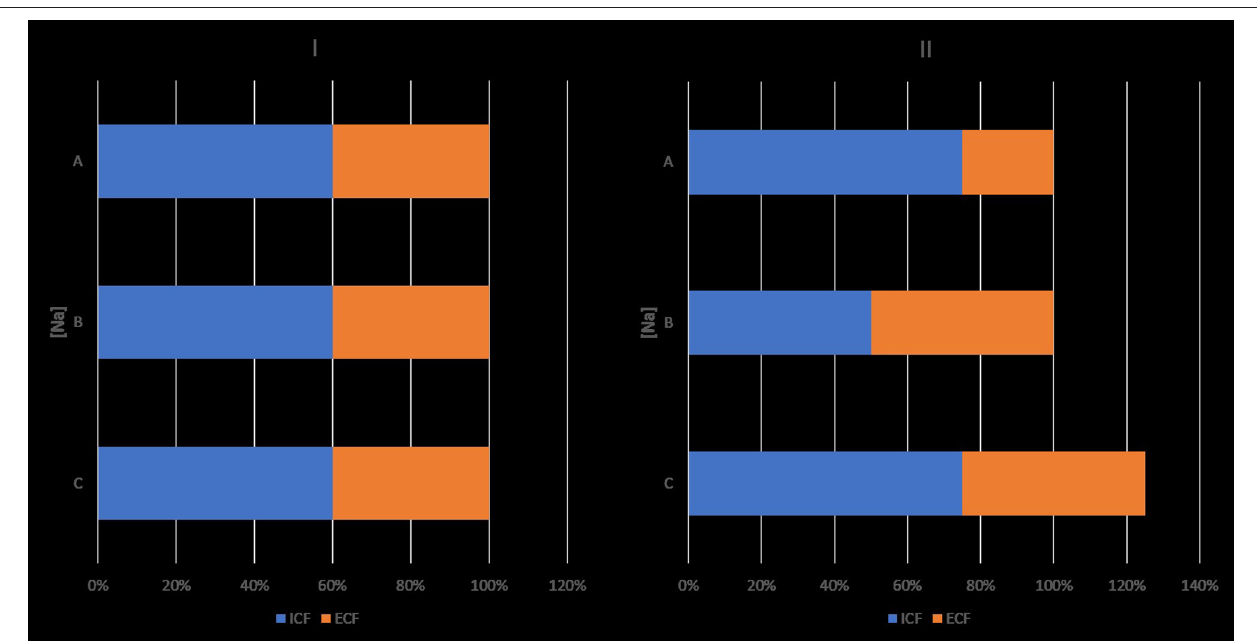
FIGURE 1 | Effects of isolated decreases in total body sodium or total body potassium, and isolated increase in total body water on sodium concentration in serum water and on intracellular and extracellular volumes. Ordinates. sodium concentrations ([Na]). Abscissae: volumes. I: baselines state. II: state after an isolated change. ICV, intracellular volume; ECV, extracellular volume; ICV + ECV = TBW. Product of ordinate and abscissa: amount of monovalent cation in intracellular or extracellular compartment. II, A: decrease in TBNa, which results in hyponatremia, increase in ICV and decrease in ECV. B: decrease in TBK resulting in hyponatremia, decrease